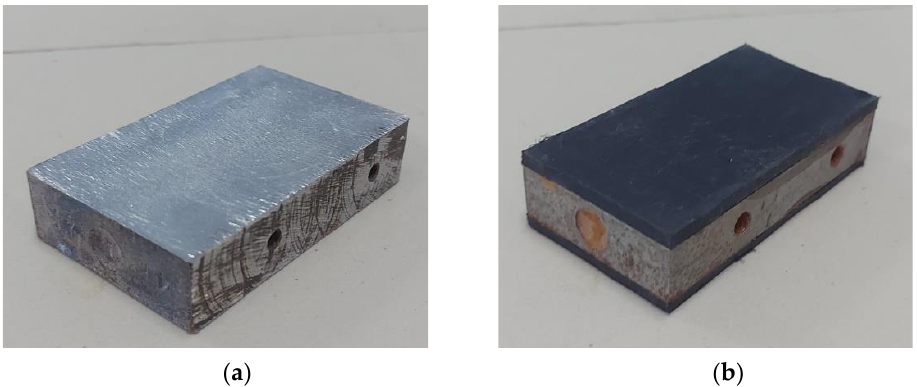
Figure 3. Uncovered steel pile model ( a ) and steel pile model with a Reline jacket ( b